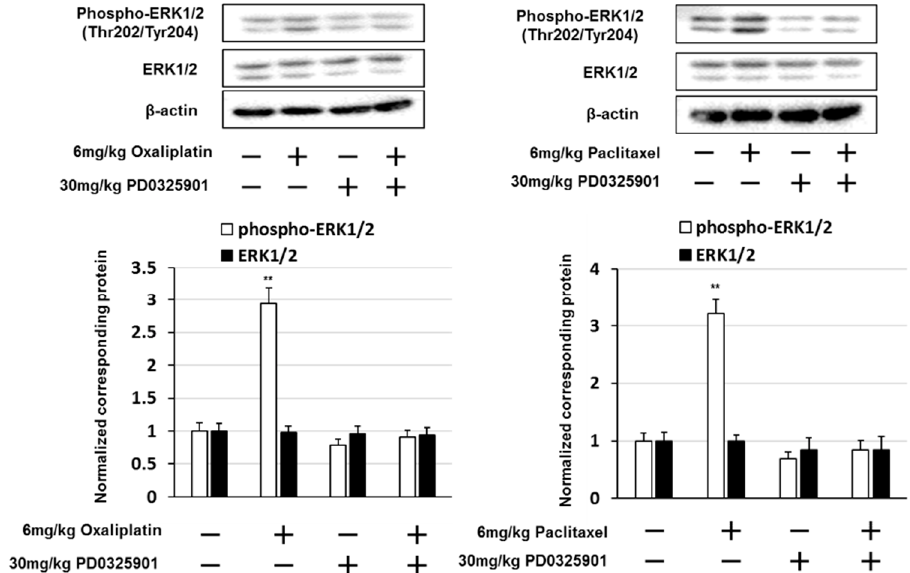
Figure 8. PD0325901 inhibited oxaliplatin- and paclitaxel-induced extracellular signal-regulated kinase 1/2 (ERK1/2) activation. Western blotting was conducted to analyze phosphorylated ERK1/2 (phospho-ERK1/2) protein expression in the spinal cord (L4–L6) obtained from mice on day 14 after treatment with oxaliplatin, paclitaxel, or PD0325901. β -actin was used as a protein loading control. Quantification of phospho-ERK1/2 and ERK1/2 expression, normalized against that of β -actin. The results show four independent experiments. ** p < 0.01 vs. controls (Shapiro–Wilk test and ANOVA with Dunnett’s test).